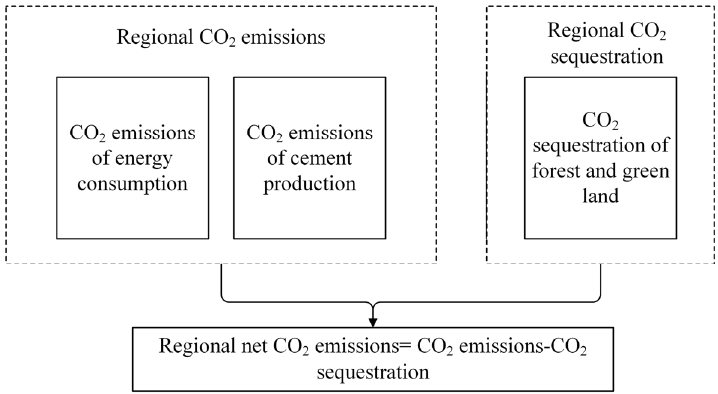
Figure 1. Regional net CO 2 emissions calculating